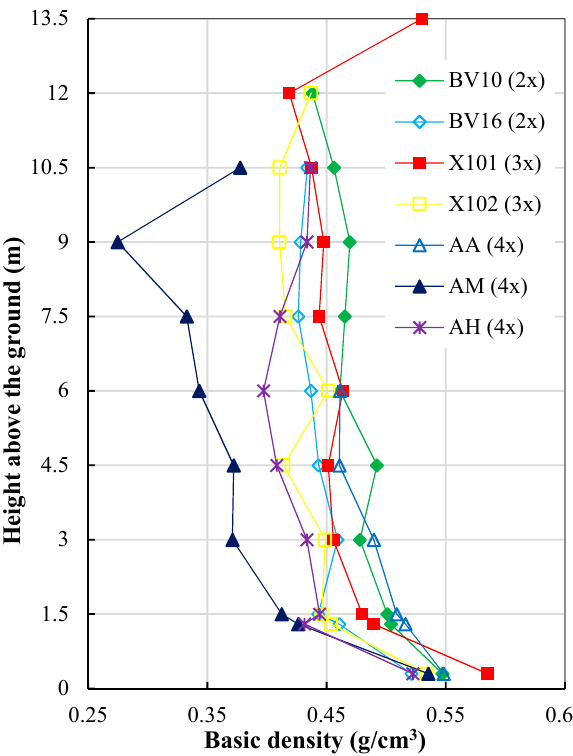
Figure 6. Profile of basic density in the axial direction.